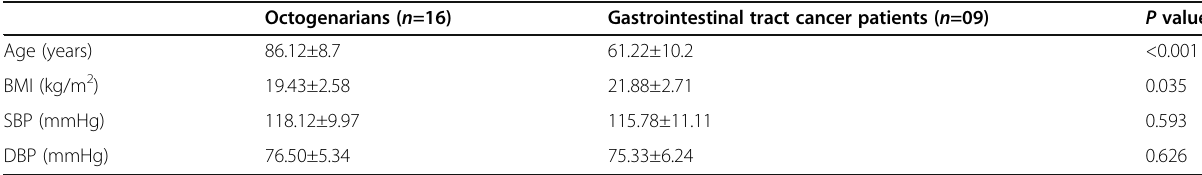
Table 1 The characteristics of the studied